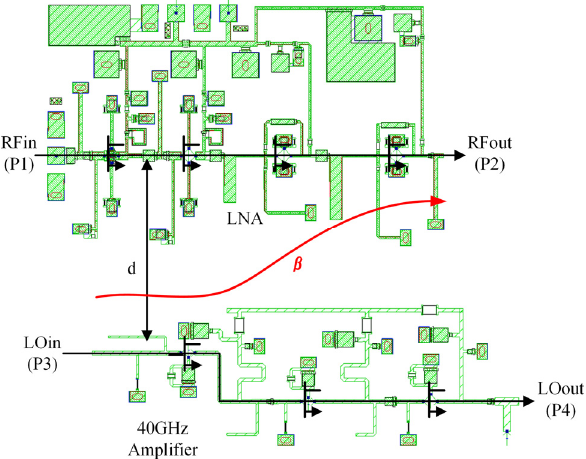
Figure 12. LNA and 40 GHz amplifier layout and their positional relationship.